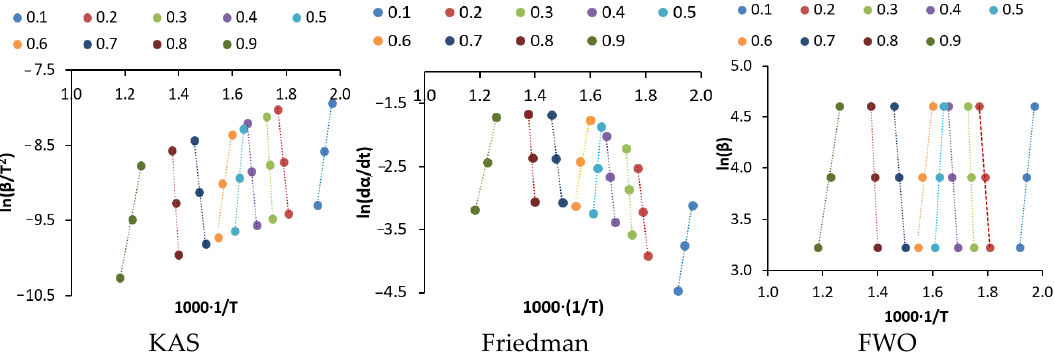
Figure 5. Plots of the KAS, Friedman and FWO methods at different conversions for sample “C”. As the data show, the activation energies varied widely. In the cases of munici- pal sewage sludge or distillery sludge, the activation energies were between 100 and 300 kJ/mol; meanwhile, the pyrolysis of samples “F” (cattle manure), “G” (chicken manure) and “H” (brook mud) resulted in slightly lower values (9.6–240 kJ/mol). The calculated activation energies are in accordance with those calculated by Liu et al.